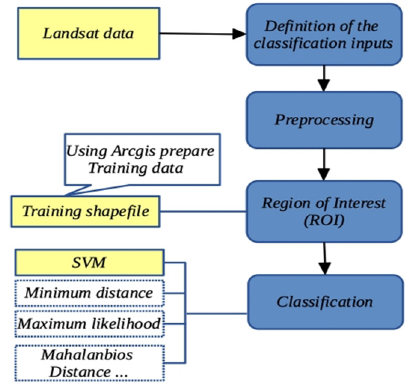
Figure 1. Landsat-image classification flow.